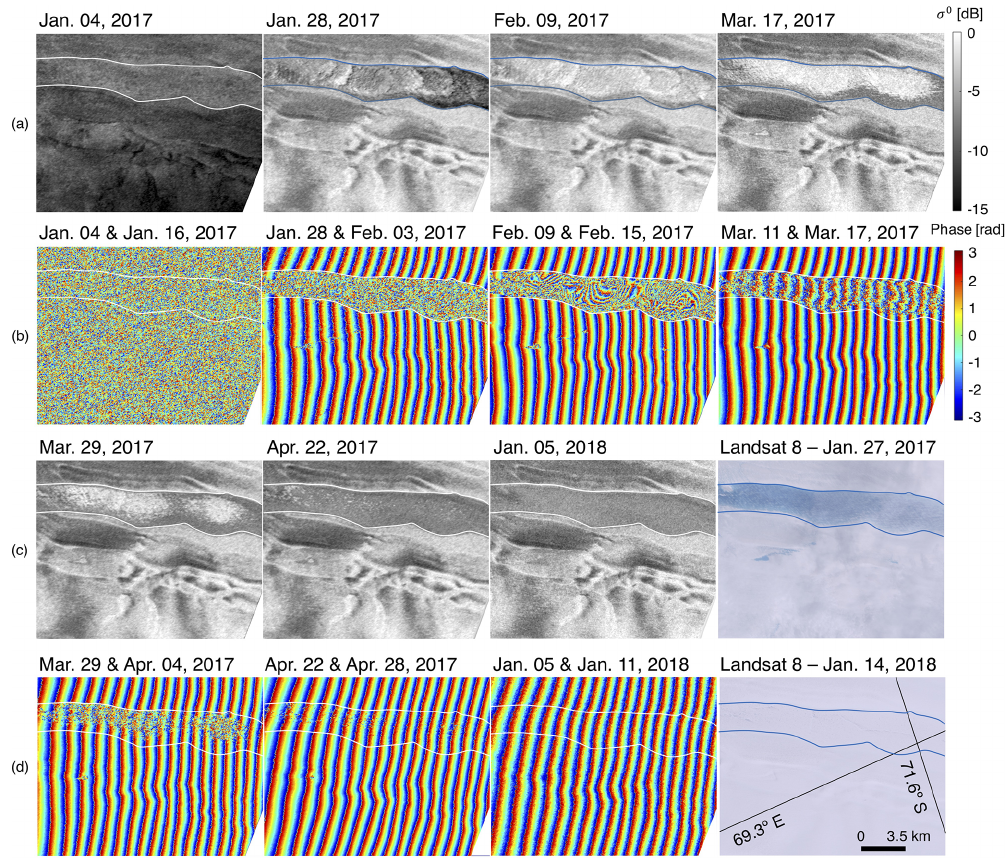
Figure 10. Sigma nought ( σ 0 ) and interferograms for a large lake in the middle of the Amery region experiencing a refreezing process; σ 0 refers to the first image of the interferogram pairs. The interferograms clearly show that the lake refreezing occurs in the first half of 2017. The lake remains frozen throughout the remainder of 2017 and in 2018. The two Landsat true colour images in the lower right corner provide a visual evaluation. The Landsat images are acquired from Google Earth Engine (Gorelick et al.,